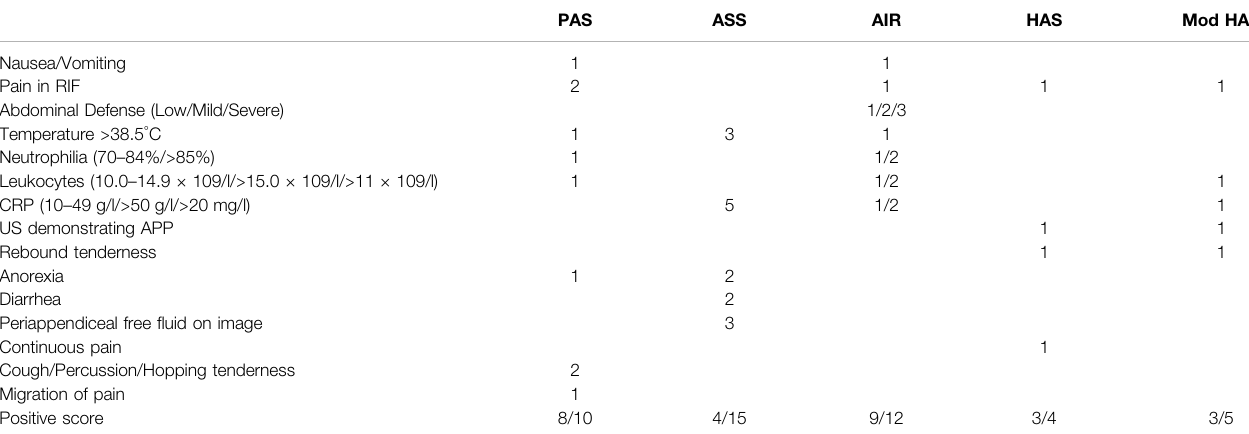
TABLE 2 | Different scoring systems for diagnosing complex appendicitis in children, including the different weighing factors for each score. PAS